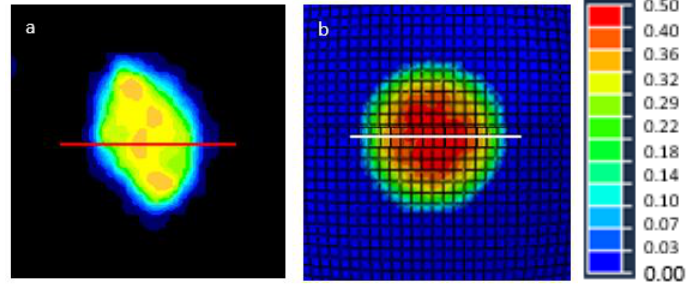
Figure 16. Surface pressure values as a function of distance for dropping an apple from a height of 10 mm on a wooden substrate.